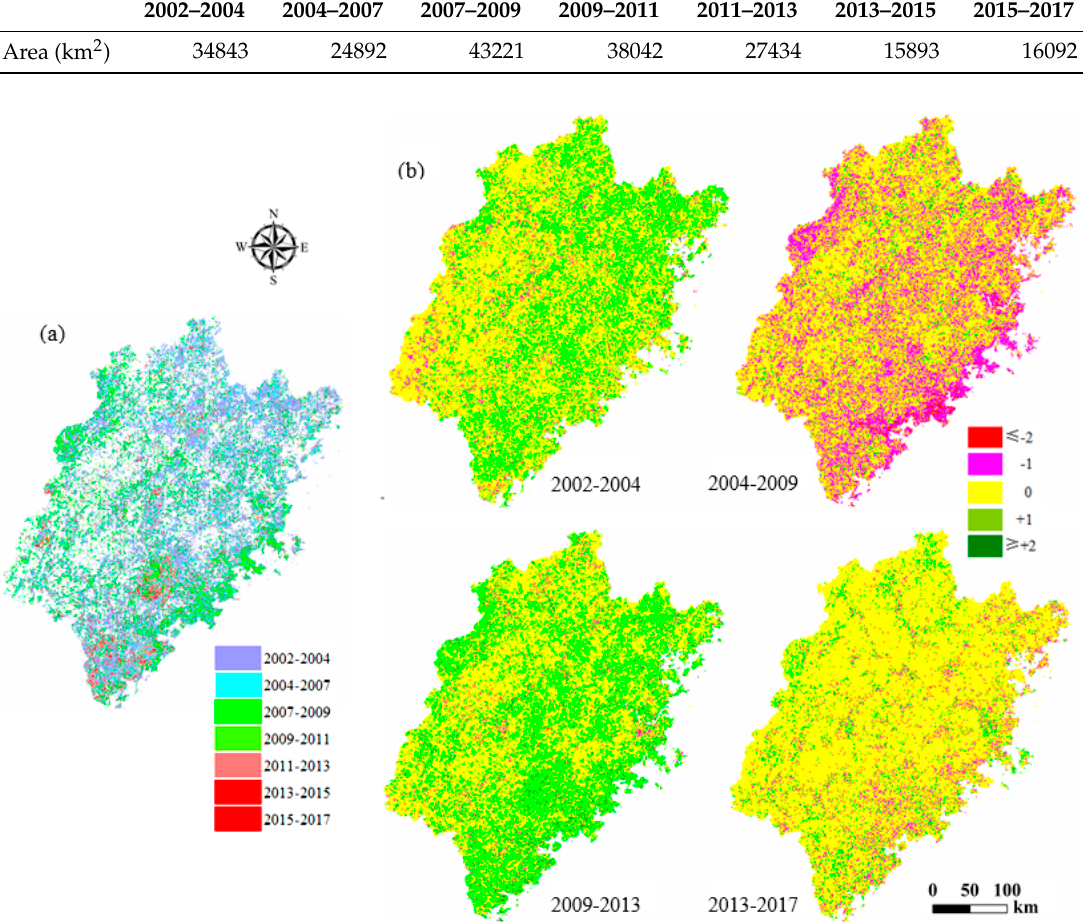
Table 4. Area statistics of ecological changes at each interval.